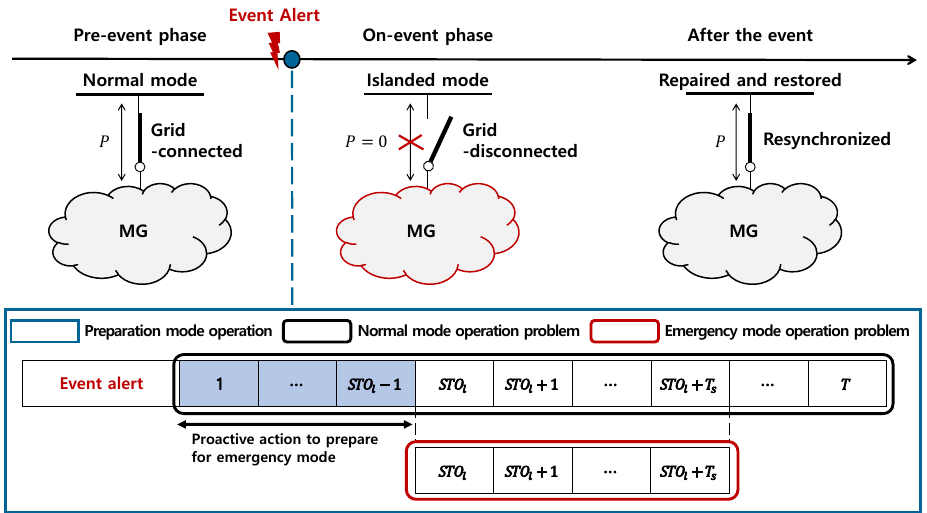
Figure 2. MG operation modes according to event phases [15,19] and the schematic of the preparation mode of the MG